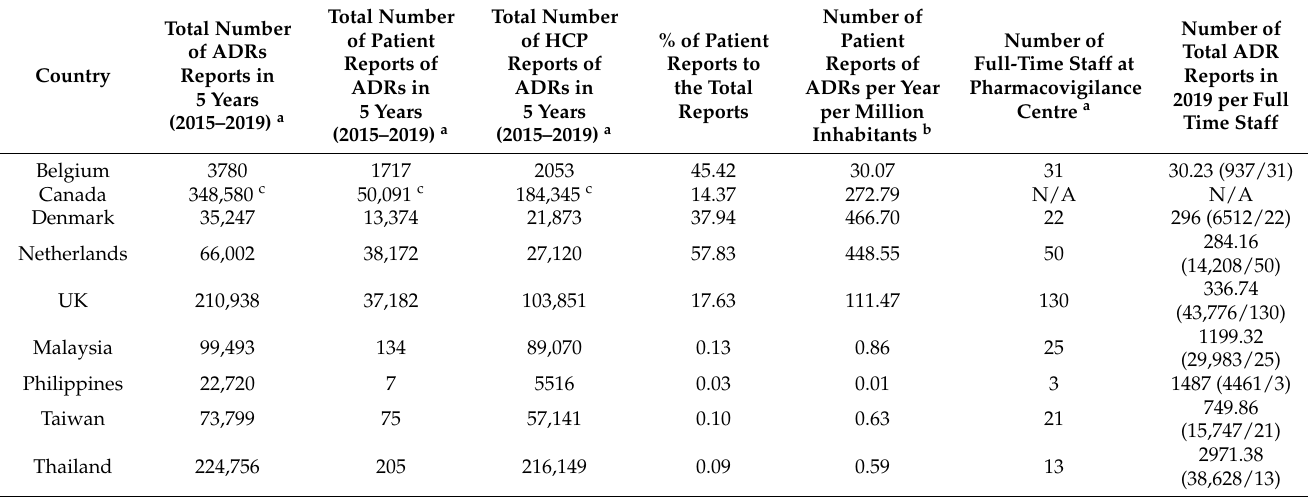
Table 1. Statistics regarding ADRs report.